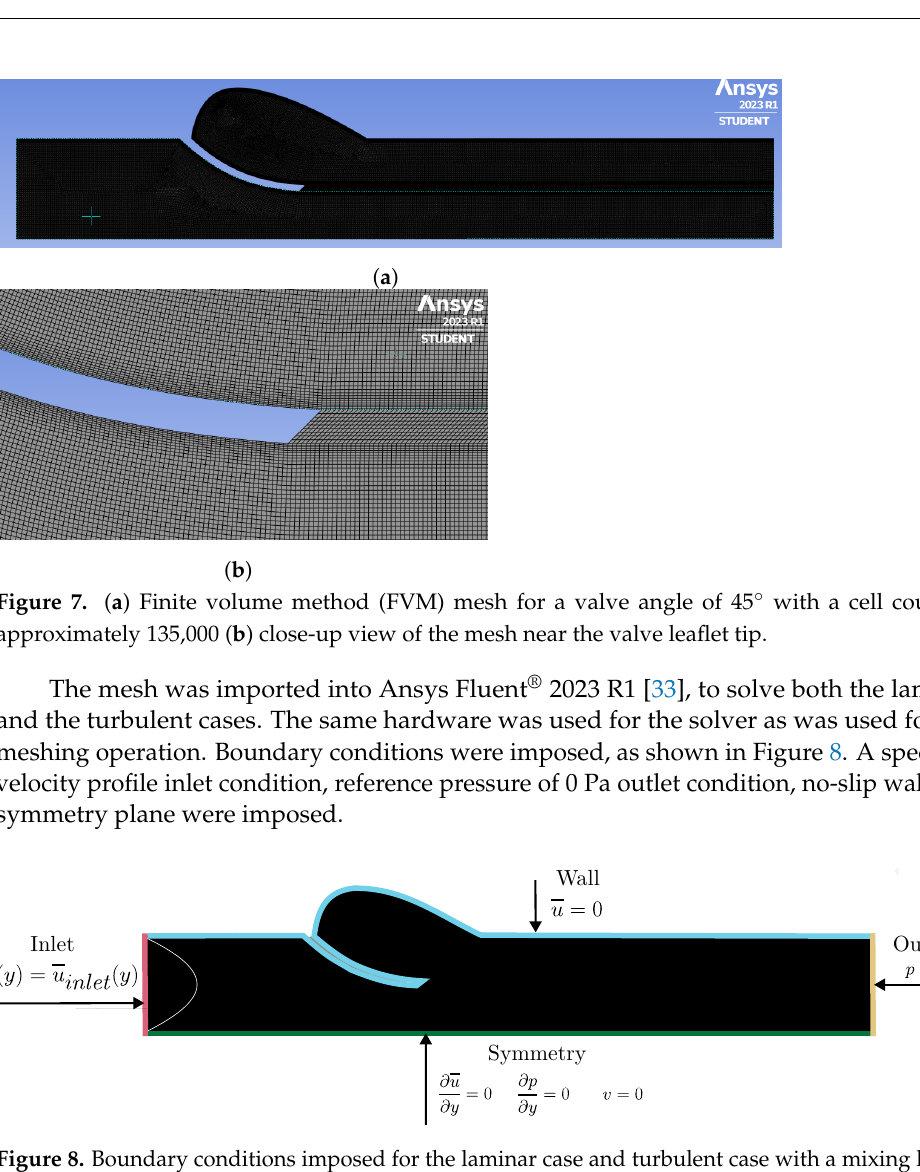
Figure 8. Boundary conditions imposed for the laminar case and turbulent case with a mixing length turbulence